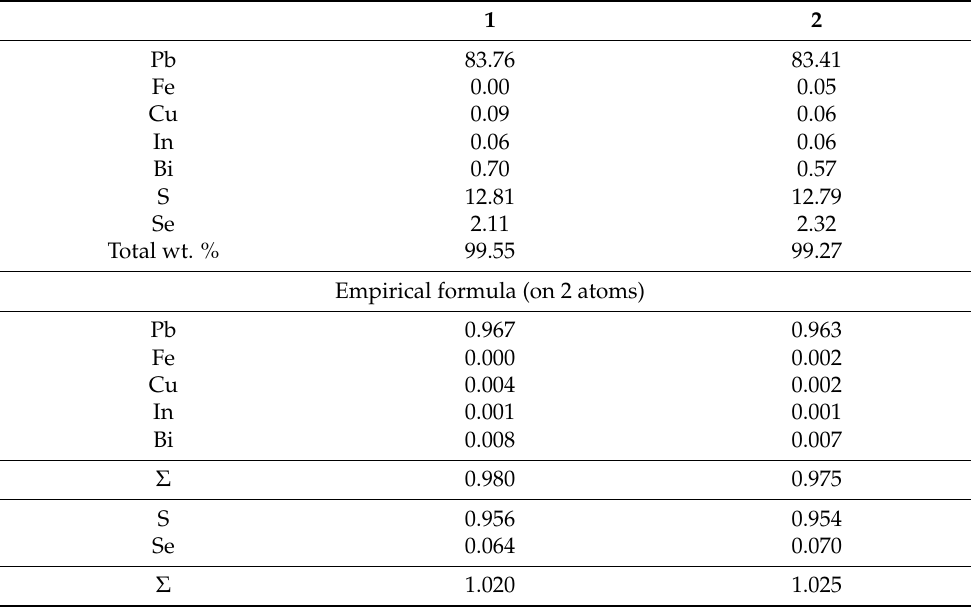
Table 13. Chemical composition of galena from ˇCuˇcma (Majersk á